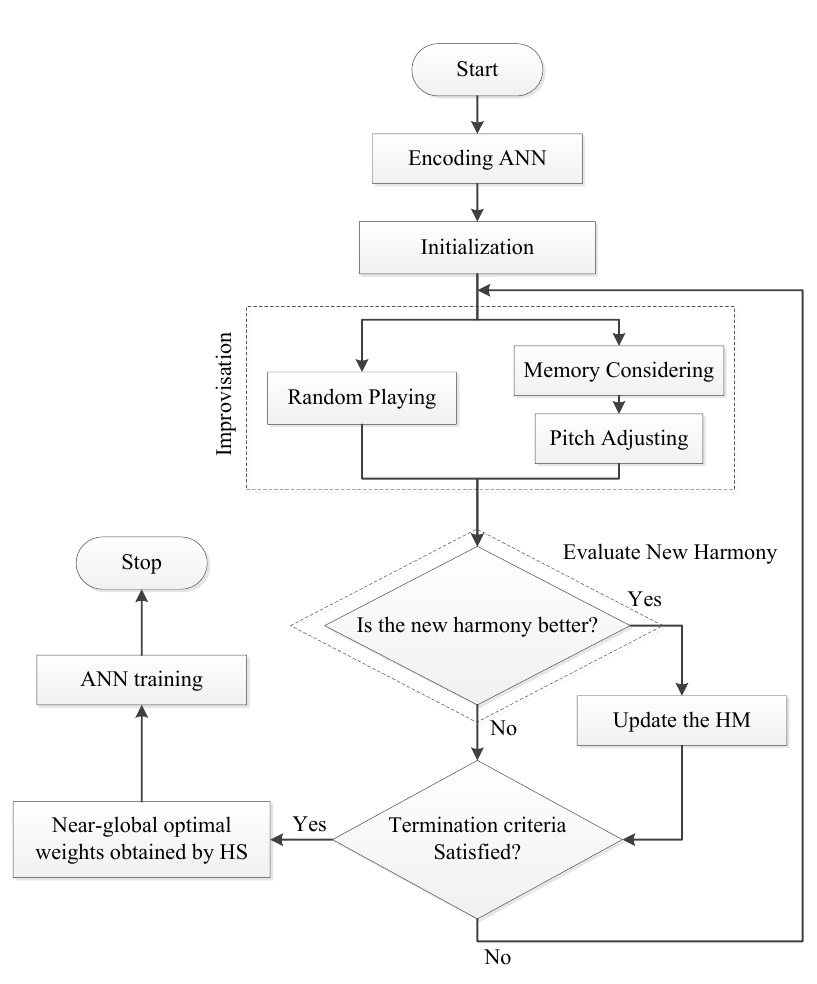
Figure 6. Flow chart of HS-ANN model.